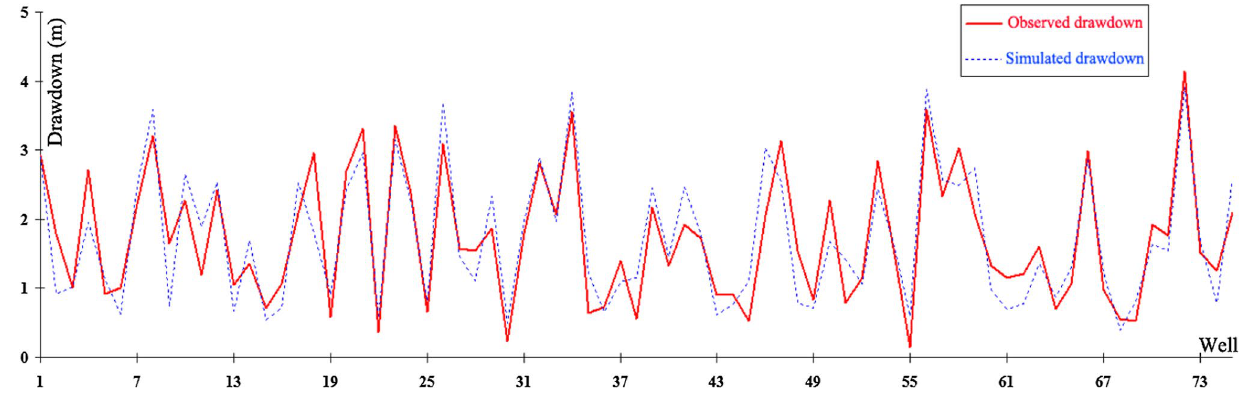
Fig. 3 Comparison between the simulated groundwater drawdown and the observed values in the test stage of the optimized CANFIS